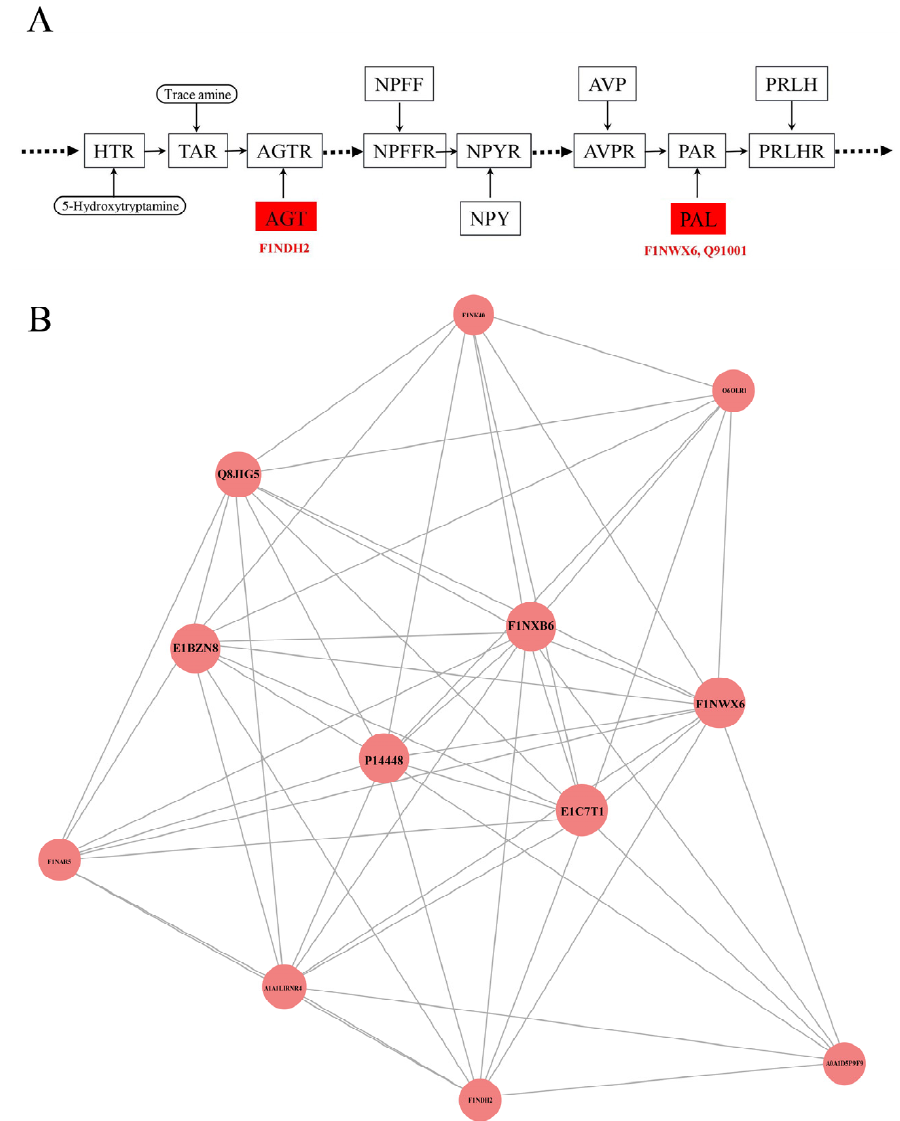
Figure 4. ( A ) Enriched plasminogen, prothrombin and angiotensin 1–10 involved in the metabolic pathway of neuroactive ligand–receptor. The up-regulated proteins in the pathways were summarized. The highly expressed AGT and PARL in SFEY are involved in the metabolic pathway of neuroactive. Square frames represent proteins in the metabolic pathway. Round frames represent small molecular metabolites. The boxes in red indicate the up-regulated proteins. HTR, 5-hydroxytryptamine receptor 2; TAR, trace amine-associated receptor; AGT, angiotensinogen II, III; AGTR, angiotensin II receptor type 1; NPFF, neuropeptide FF-amide peptide; NPFFR, neuropeptide FF receptor 1; NPY, neuropeptide Y; NPYR, neuropeptide Y receptor; AVP, arginine vasopressin; AVPR, arginine vasopressin receptor 2; PAL, proteinase-activated like; PAR, proteinase-activated receptor; PRLH, prolactin-releasing-like hormone; PRLHR, prolactin-releasing hormone receptor. ( B ) Interaction networks of differentially abundant proteins. Circle nodes: differentially abundant proteins (red: up-regulation; circle size: degree of connectivity of the protein, namely, the number of proteins that directly interact with a protein); lines: protein–protein interactions.